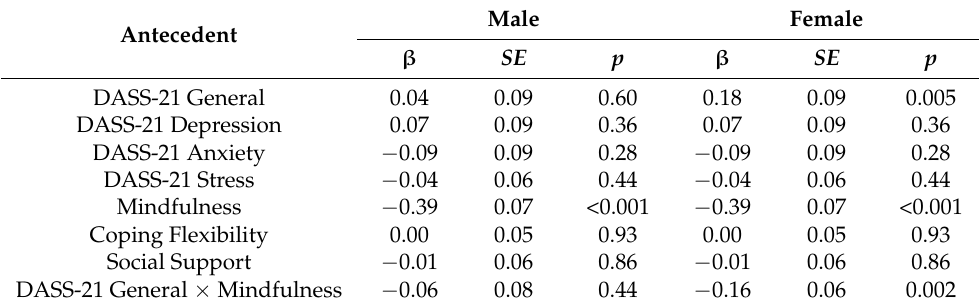
Table 4. Latent multiple regression of IGD tendency with moderating testing across two countries (Model 10).